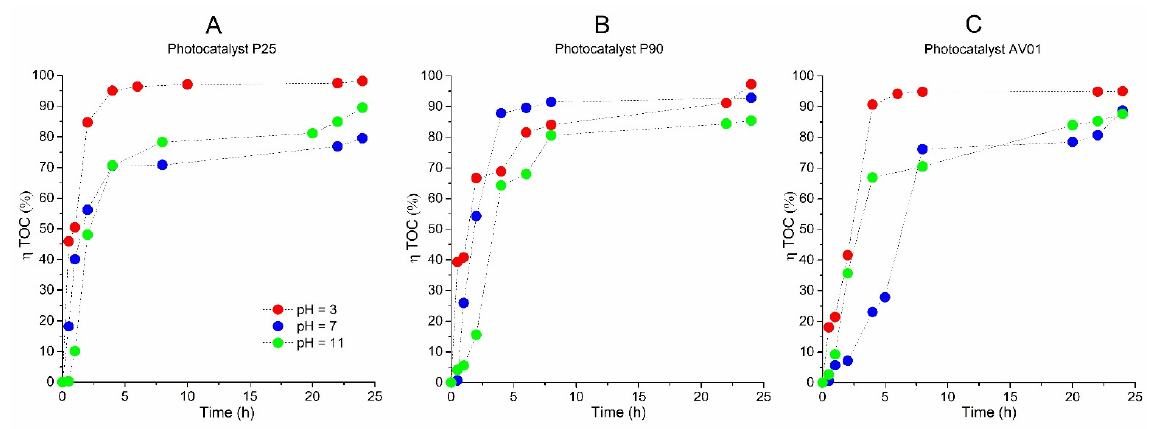
Figure 5. The efficiency of AB80 photocatalytic mineralization in the heterogeneous phase at t = 25 °C, expressed by a relative decrease in TOC: ( A ) P25, ( B ) P90, ( C ) AV01.